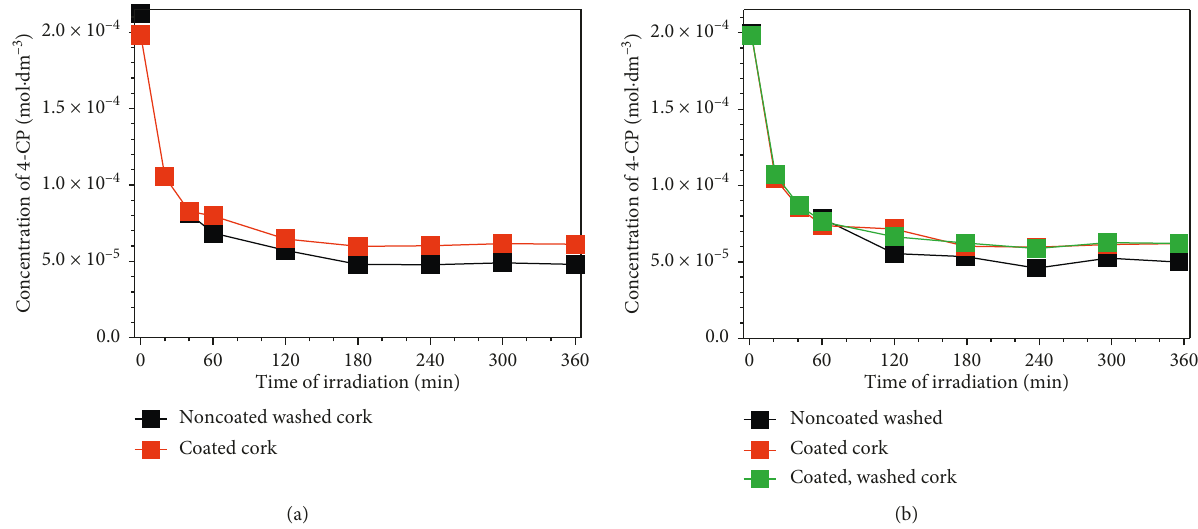
Figure 3: (a) Blank—sorption of 4-CP on Noncoated washed cork and coated cork. (b) Photocatalytic degradation of 4-CP (in laboratory photoreactor at a stirring rate of 500rpm) using noncoated washed, coated, and coated, washed cork.